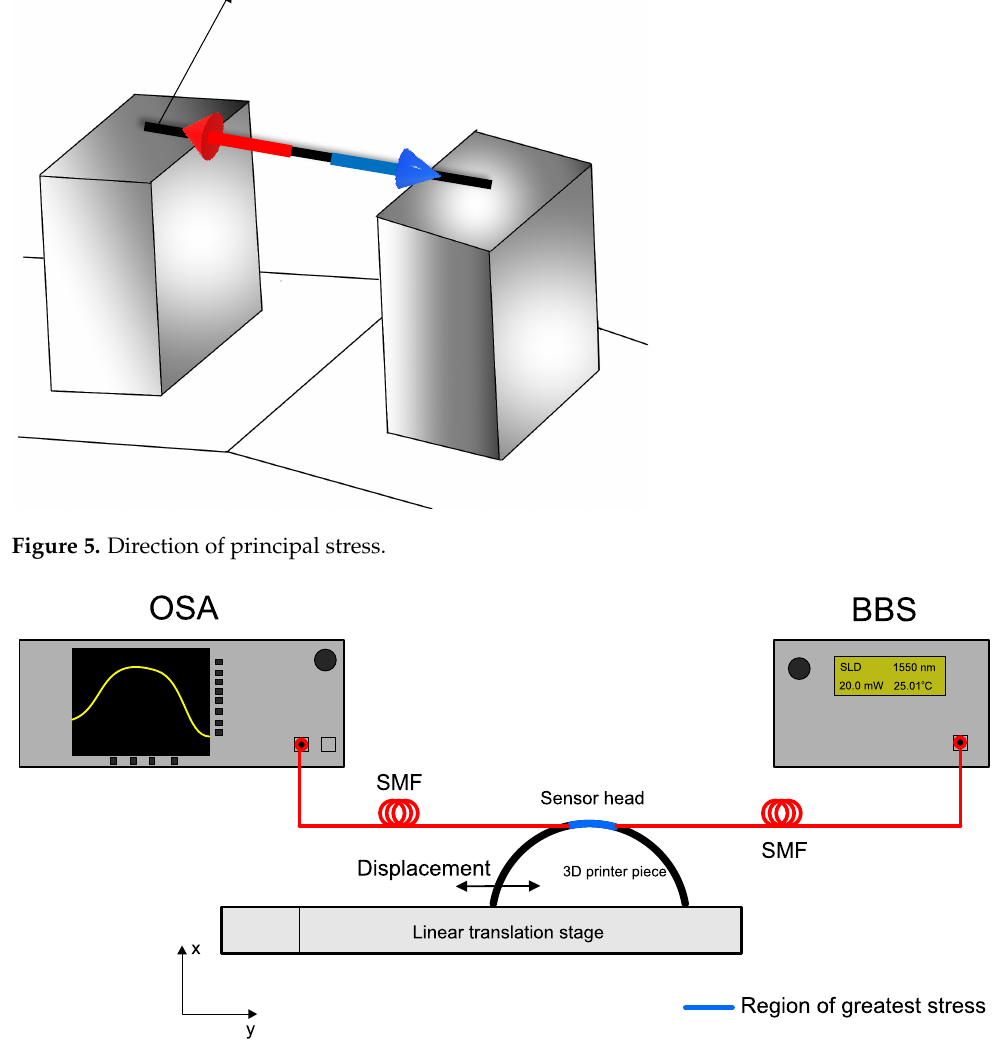
Figure 6. Schematic of the experimental setup for the diameter analysis that demonstrates the diameter reduction using a linear translation